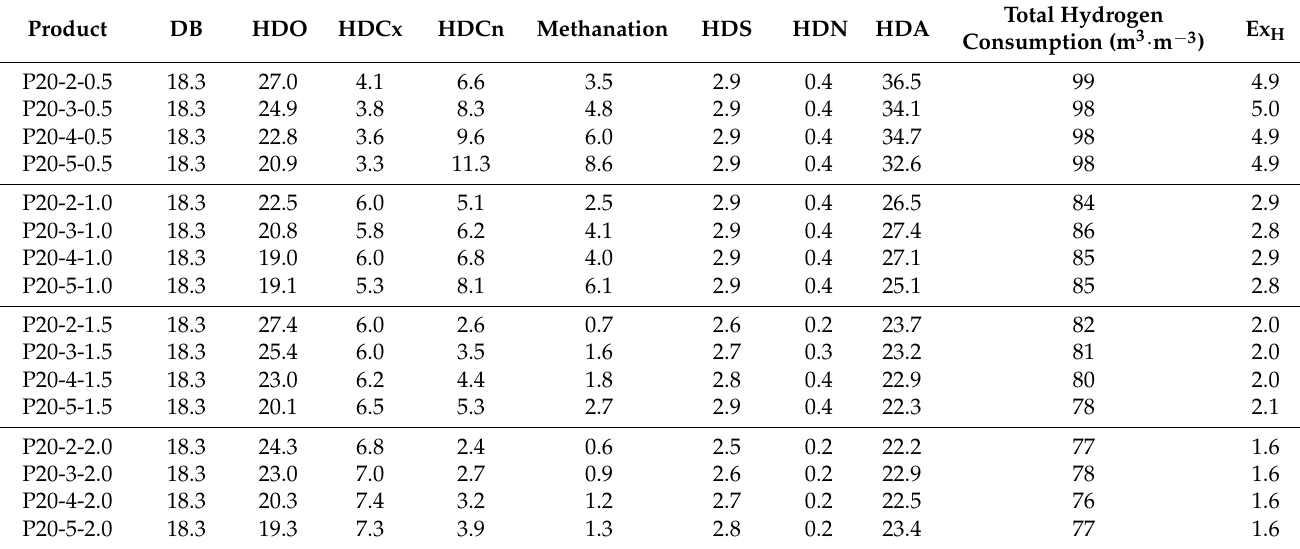
Table 10. The hydrogen consumption (m 3 · m − 3 ) for the individual reactions, total hydrogen consumption and hydrogen excess (Ex H ) in the hydrotreating of the F20 feedstock.